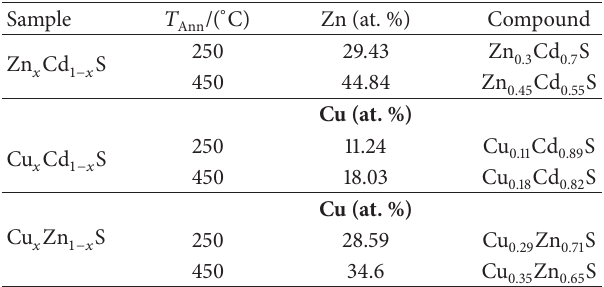
Table 1: Mean compositions in at. %, determined by EDS of the (vacuum-annealed) ternary semiconductor